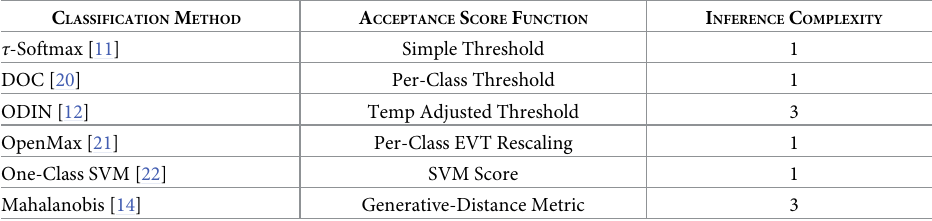
Table 1. The studied inference methods for OOD detection. Inference complexity refers to the number of passes through a deep CNN (forward and backward) during inference. C LASSIFICATION M